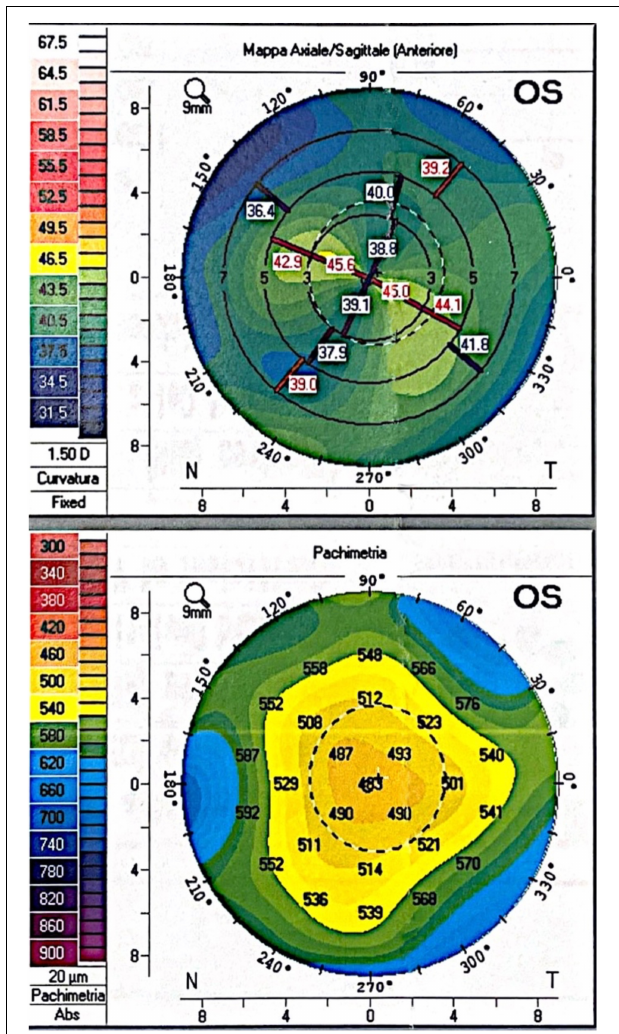
FIGURE 2 | Fifteen months postoperative corneal topography and pachymetry.